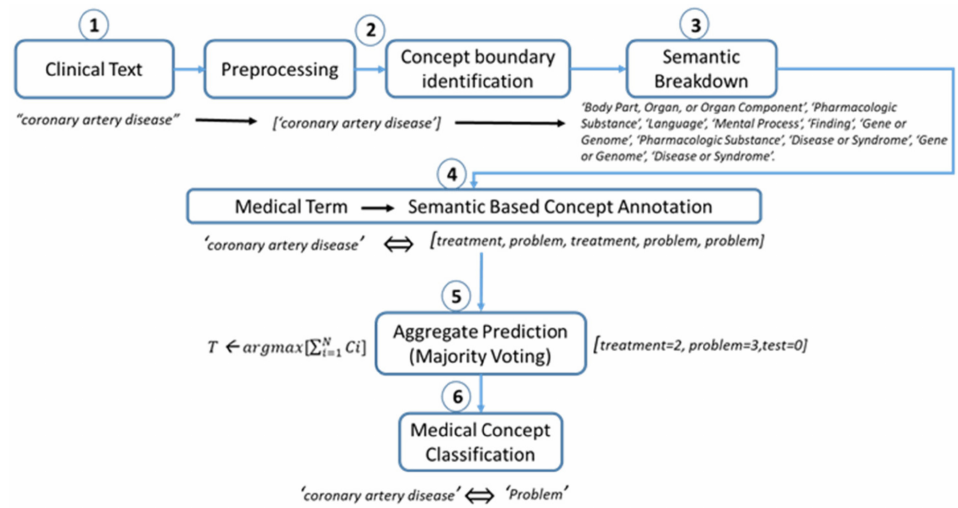
Figure 5. A step-by-step process of medical concept classification using majority